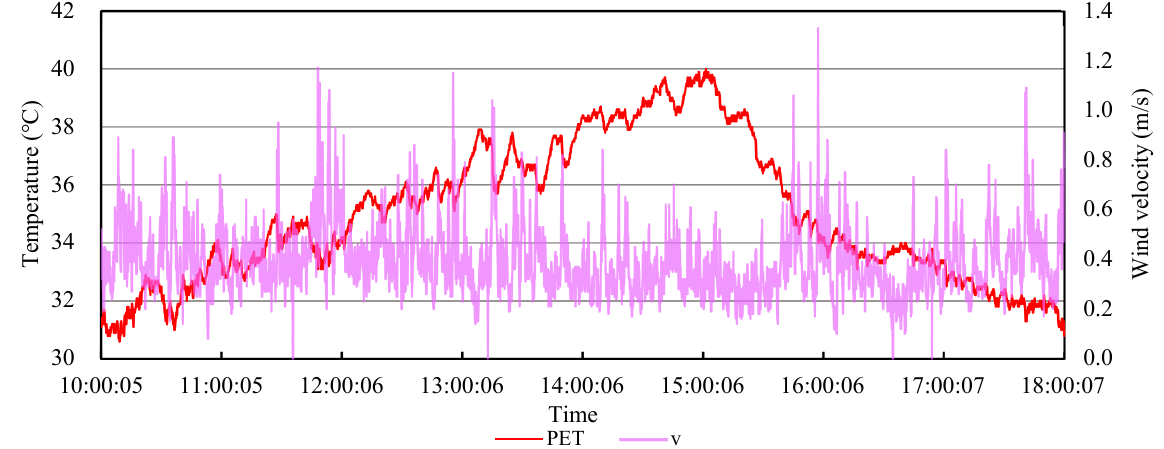
Figure 4. Temporal trend of strongly correlated thermal comfort parameters.